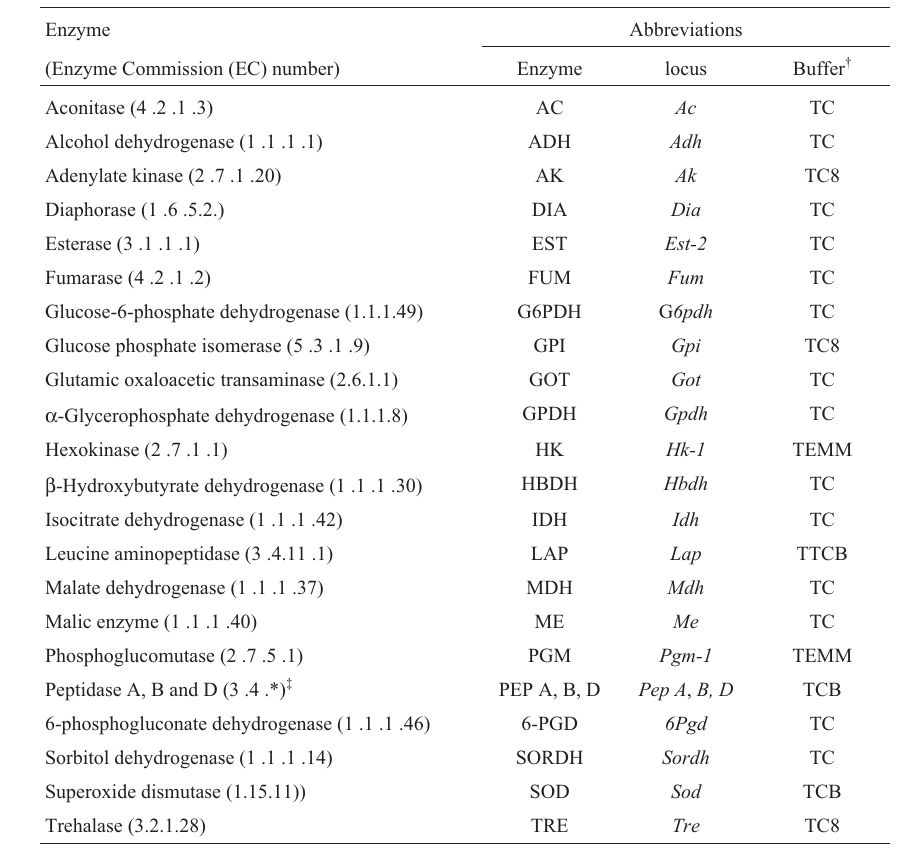
Table 1 - The 22 enzyme systems analyzed.